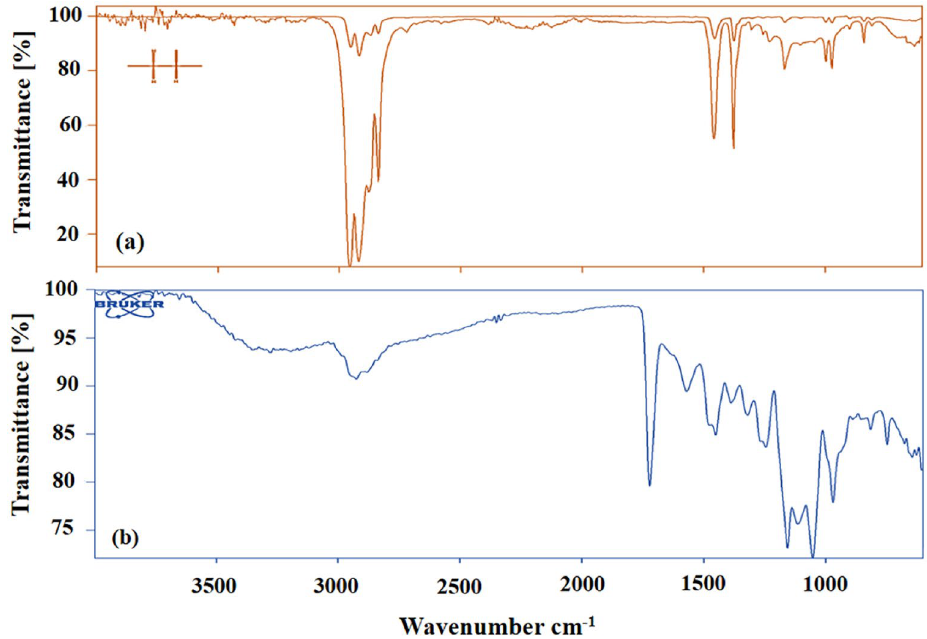
Figure 3. ( a ) Infrared spectra analysis of PP-nonwoven fabric; ( b ) Infrared spectra analysis of amine group modified PP-g-(GMA-co- H